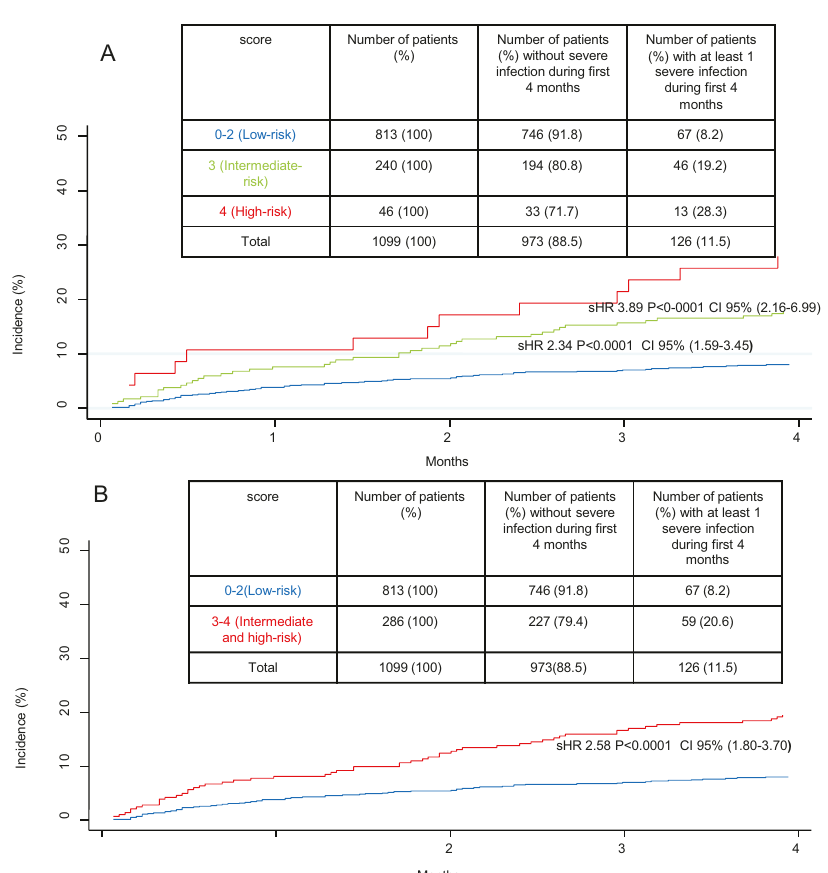
Fig. 5 Cumulative incidence of early severe infection according to risk group by Score GEM. A Three risk groups with different probabilities of early severe infection. B Two risk group when intermediate and high risk were grouped. sHR sub-Hazard ratio, CI 95% con fi dence